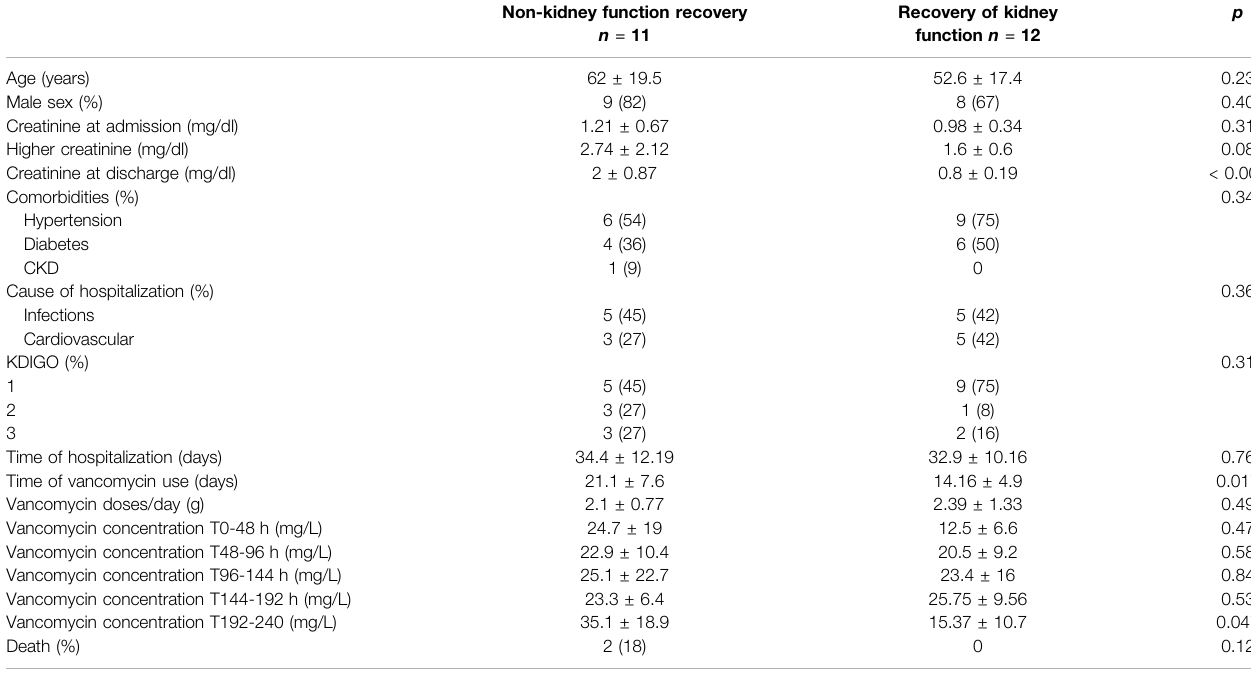
TABLE 5 | Demographics and clinical characteristics of AKI patients according to the recovery of kidney function at hospital discharge.